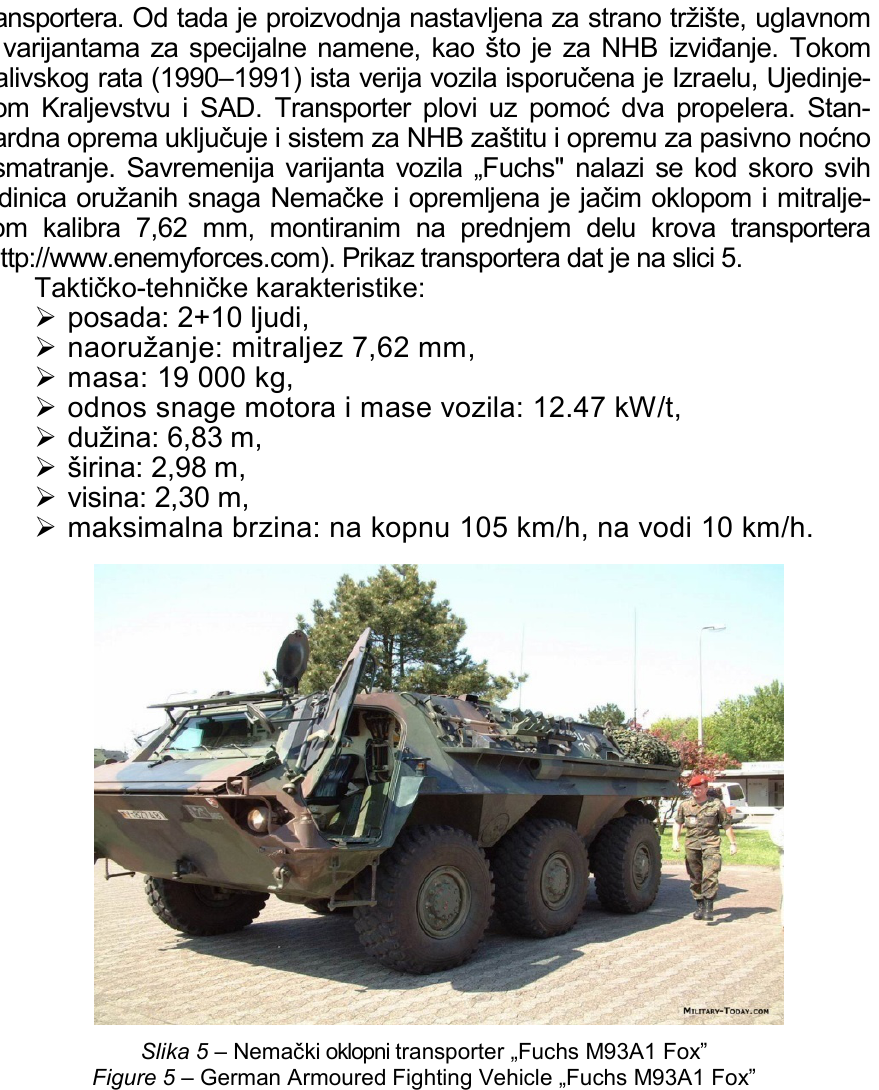
Figure 5 – German Armoured Fighting Vehicle „Fuchs M93A1 Fox” Nema č ka amfibijska skela